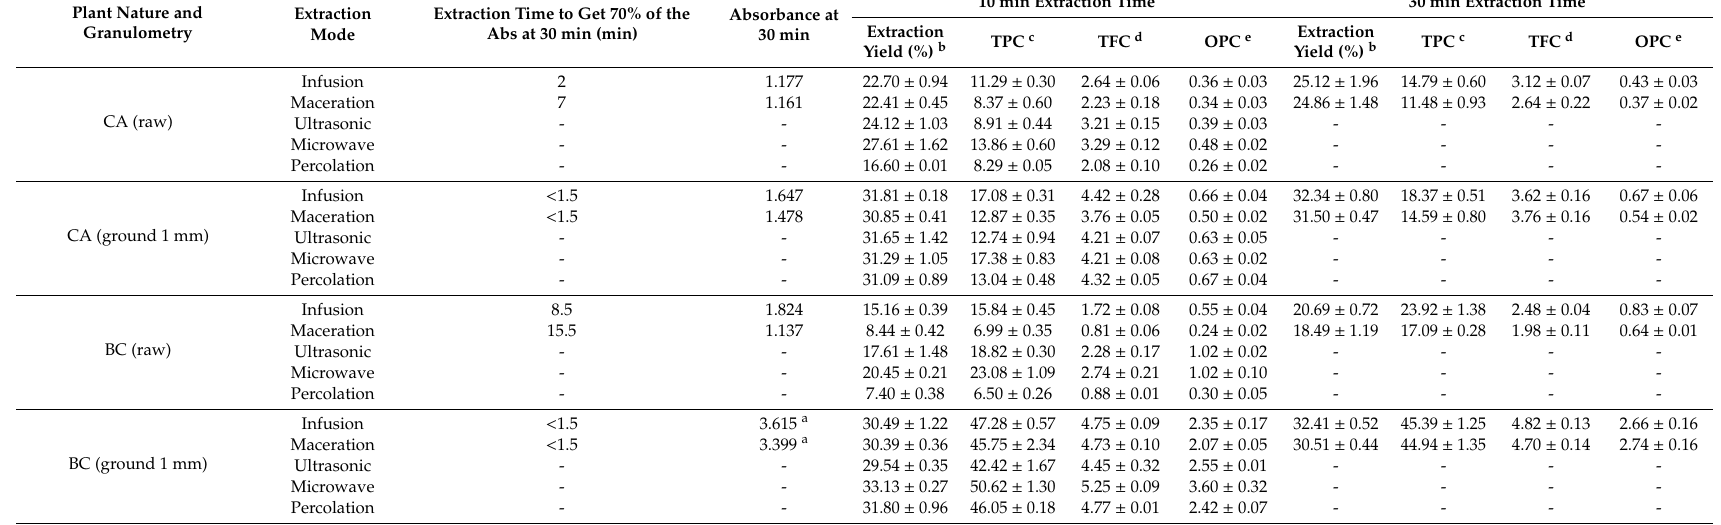
Table 2. Physicochemical characteristics of the extracts of CA and BC depending on the extraction time, the extraction mode, and the plant granulometry. A total of 2.5 g of plant material in 250 mL water was systematically used. In total, 100 µ L of herbal tea solution was taken and added to 4 mL water before UV measurement, except for a , where 100 µ L was added to 8 mL water to avoid spectrometer saturation (reported values were then multiplied by 2 for pertinent comparison). b : ± 1 standard deviation ( n = 3 repetitions). c : in mg equation GA / g dry plant, ± one standard deviation ( n = 3 repetitions). d : in mg equation Q / g dry plant, ± 1 SD ( n = 3